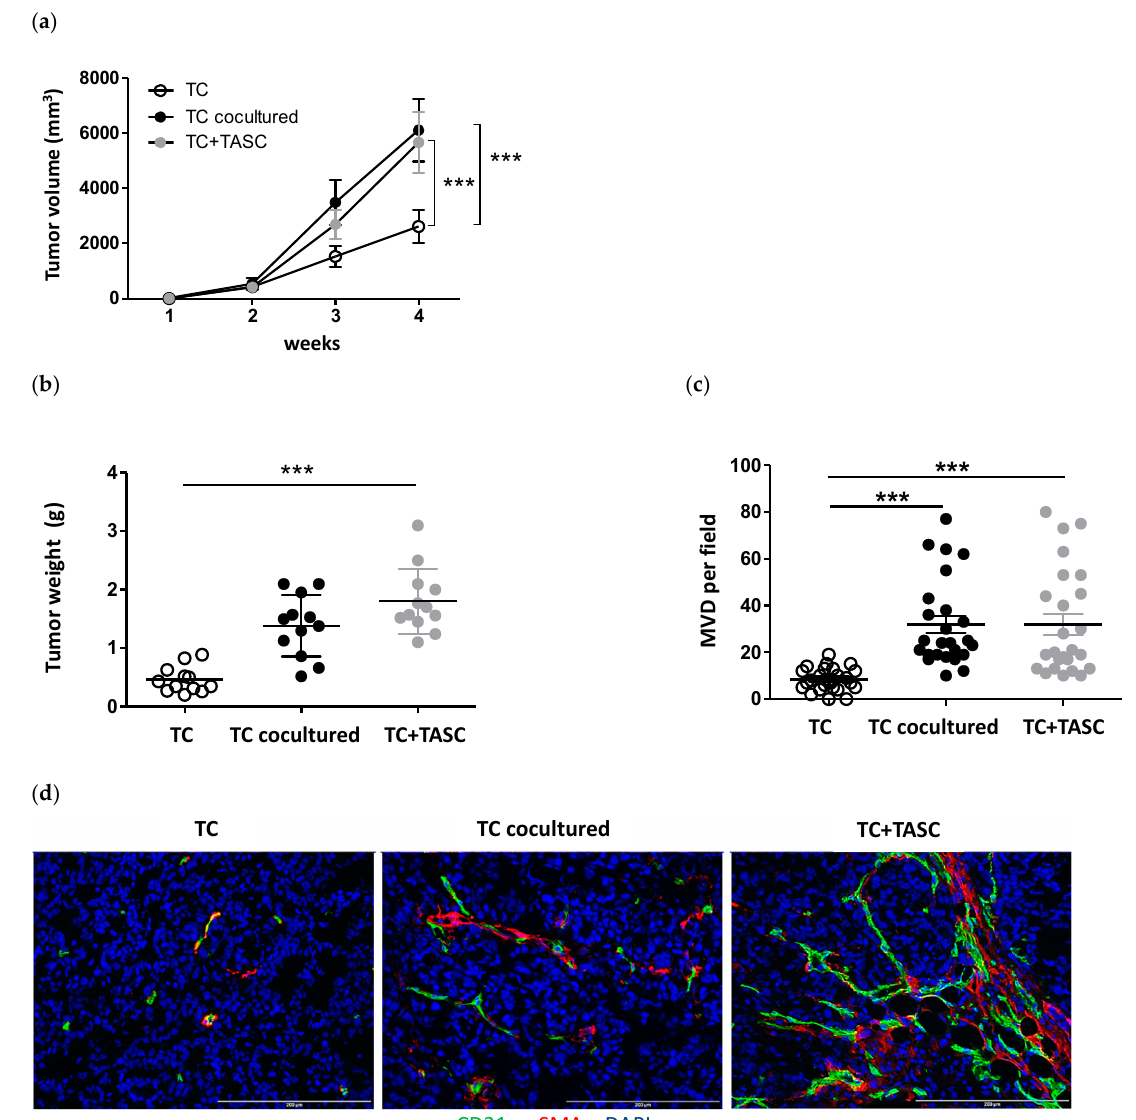
Figure 3. TASCs promote tumor development in a heterotopic tumor xenograft model. ( a ) Growth kinetics of tumors developed upon s.c. injection of tumor cells alone (TC), cocultured with TASCs and sorted prior to injection (TC cocultured), or cultured alone and admixed with TASCs prior to injection (TC+TASC). Mean values ± SD from three independent experiments performed with different TASCs (total mice injected n = 12/experimental group) are reported (Mann–Whitney test, *** p ≤ 0.001). ( b ) Tumor weights measured at the end of the experiment. Individual values from three independent experiments (mice injected n = 12/experimental group) are shown. Means ± SD are indicated by bars (Mann–Whitney test, *** p ≤ 0.001). ( c ) Microvessel density (MVD) quantification in developed tumors. Numbers of CD31+ cells per field are reported. Data refer to individual values from three independent experiments ( n = 12 mice/experimental group, 2 fields/tumor). Means ± SD are indicated by bars (Mann–Whitney test, *** p ≤ 0.001). ( d ) Representative immunofluorescence staining of CD31 (green), α -SMA (red), and DAPI (blue) on tumor sections. Magnifications 20 × , scale bar 100 µ